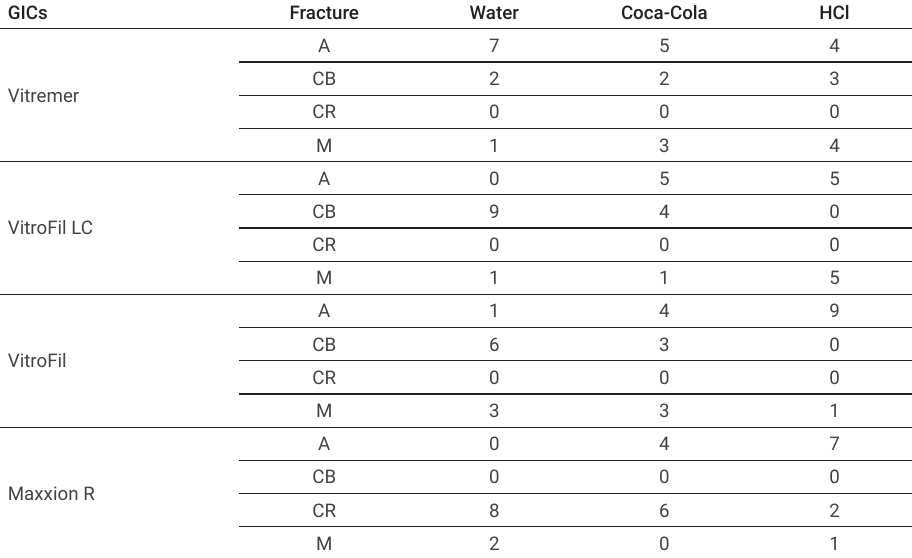
Table 4. Analysis of fracture after shear bond test. GICs Fracture Water Coca-Cola HCl A Vitremer